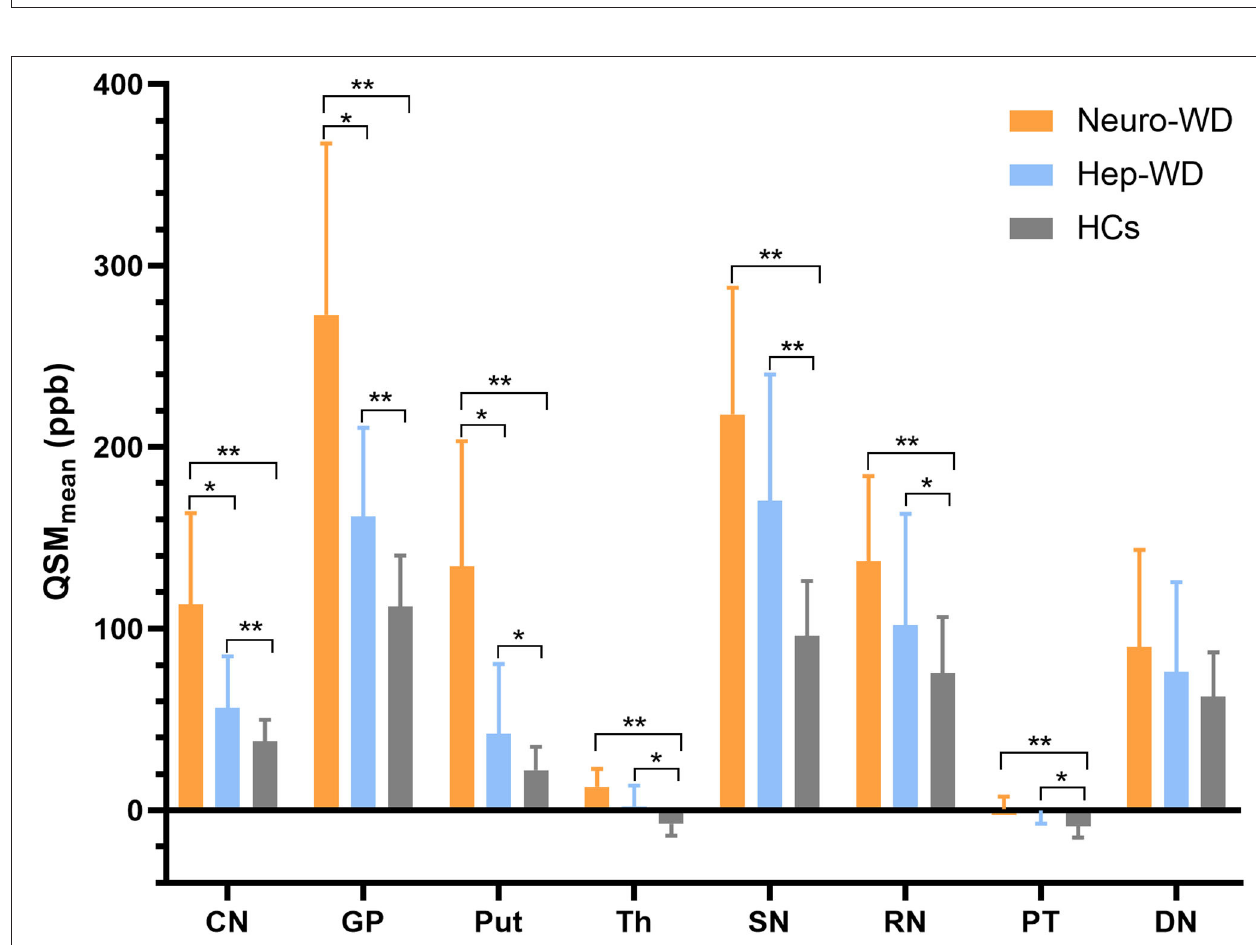
FIGURE 3 | Comparison of mean bulk susceptibility values between different groups. Comparison between healthy control (HCs) and patients with WD: * p < 0.017 and ** p < 0.001. Comparison between patients with neuro-WD and patients with hep-WD. Error bars indicate standard deviation. CN, head of the caudate nucleus; DN, dentate nucleus; GP, globus pallidus; Put, putamen; RN, red nucleus; SN, substantia nigra; Th, thalamus; PT, pontine tegmentum.